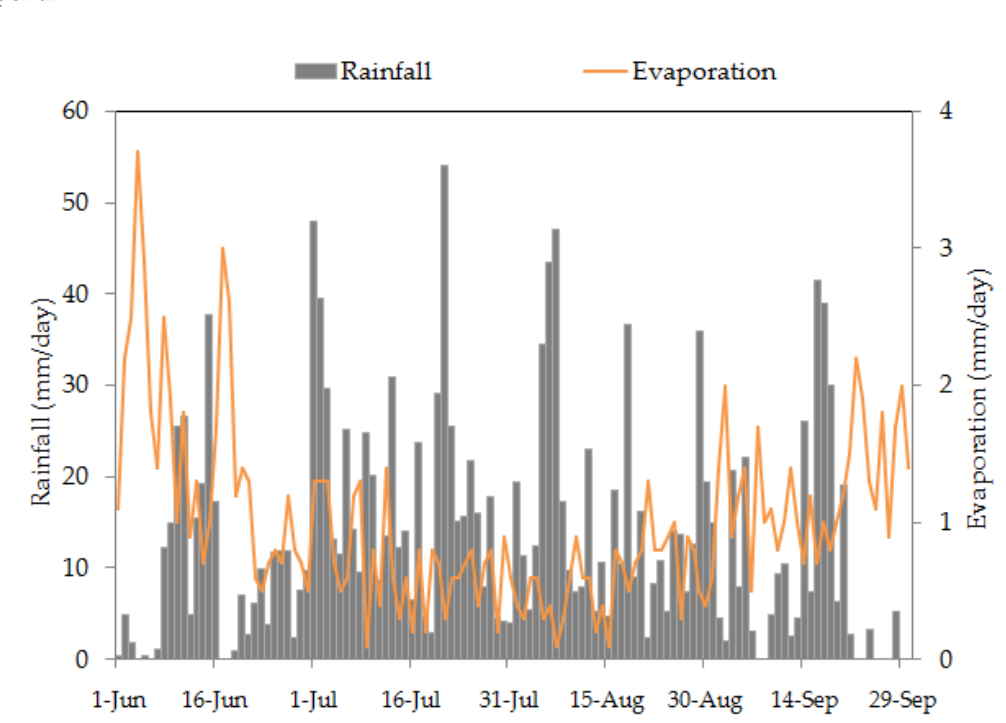
Figure B1. Weather characteristics of the Anjeni watershed in 2013.